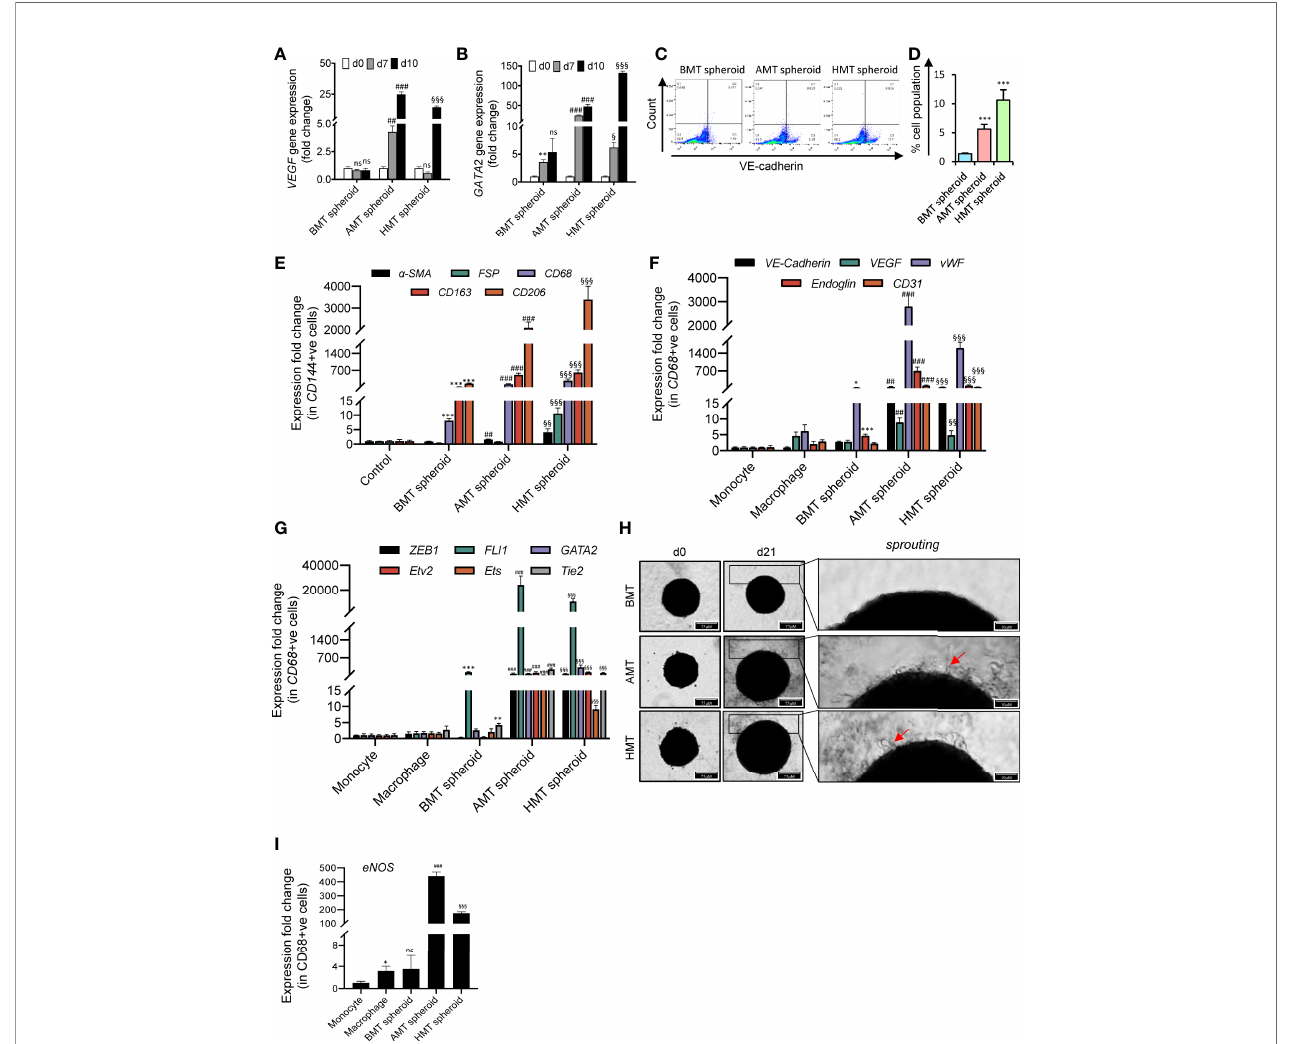
FIGURE 5 | Angiogenic potential of malignant 3D multicellular spheroids. (A, B) RT-qPCR analysis of endothelial cell markers gene expression such as VEGF (A) and GATA2 (B) in BMT, AMT, and HMT spheroids on day 0, day 7, and day 10. (C, D) Flow cytometric analysis (C) and quanti fi cation (D) of VE-cadherin+ cells in BMT, AMT, and HMT spheroids on day 10. (E) RT-qPCR analysis of a-SMA , FSP , CD68 , CD163 , and CD206 mRNA levels in CD144+ cells isolated from BMT, AMT, and HMT spheroids on day 14. (F, G) RT-qPCR analysis of endothelial cell markers ( VE-cadherin, VEGF, vWF, Endoglin, and CD31 ) (F) and angiogenic regulators ( ZEB1, FLI1, GATA2, Etv2, Ets, and Tie2 ) gene expression (G) in THP-1 macrophages and CD68+ cells, respectively, isolated from BMT, AMT, and HMT spheroids on day 14h. (H) . Representative images of BMT, AMT, and HMT spheroids on day 21 after placing the spheroid of day 14 on a collagen matrix and maintained in endothelial cell media for 7 days. Cell sprouting (red arrow) were detected in tumor spheroids. (I) RT-qPCR analysis of eNOS gene expression in CD68 + cells of these spheroids on day 21. GAPDH was used as loading control for RT-qPCR analysis. Fold change for CD144+ cells was calculated keeping the 2Dcells (control)at day 0as control and fold change for CD68+ cells was calculated keeping THP-1 monocytes (2D) as control. All experiments were performed in triplicates (n = 3). Data represented as mean ± S.D. 2D vs BMT over time *p< 0.05, **p< 0.01, ***p< 0.001; BMT vs AMT over time ## p< 0.01, ### p< 0.001; BMT vs HMT over time § p< 0.05, §§ p< 0.01, §§§ p< 0.001; ns, non-signi fi